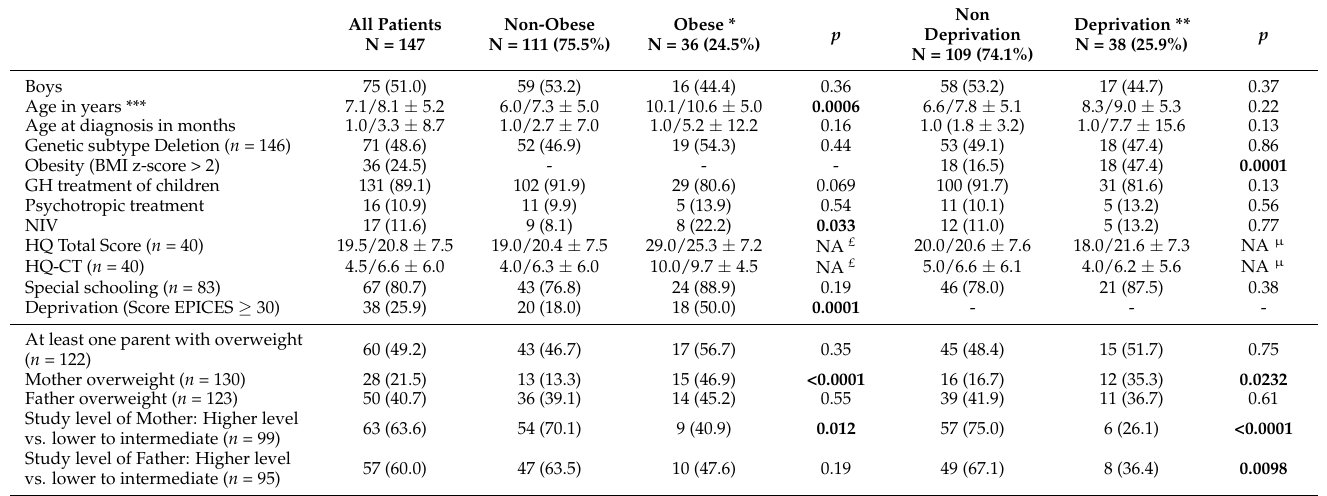
Table 1. Characteristics of children and their parents in the whole group and in the four groups, obese vs. non-obese and deprived vs. non-deprived. Variables are expressed in n (%) or in Med/Mean ± SD; for continuous variables (age, age at diagnosis, BMI Z-score, HQ, HQ-CT) P was calculated using Student or Wilcoxon test; for categorical variables (gender, genetic diagnosis, special schooling, parent’s obesity, study level of parents, treatment of GH/Psychotropic treatment, NIV, deprivation) p was calculated using Chi2 or Fisher exact